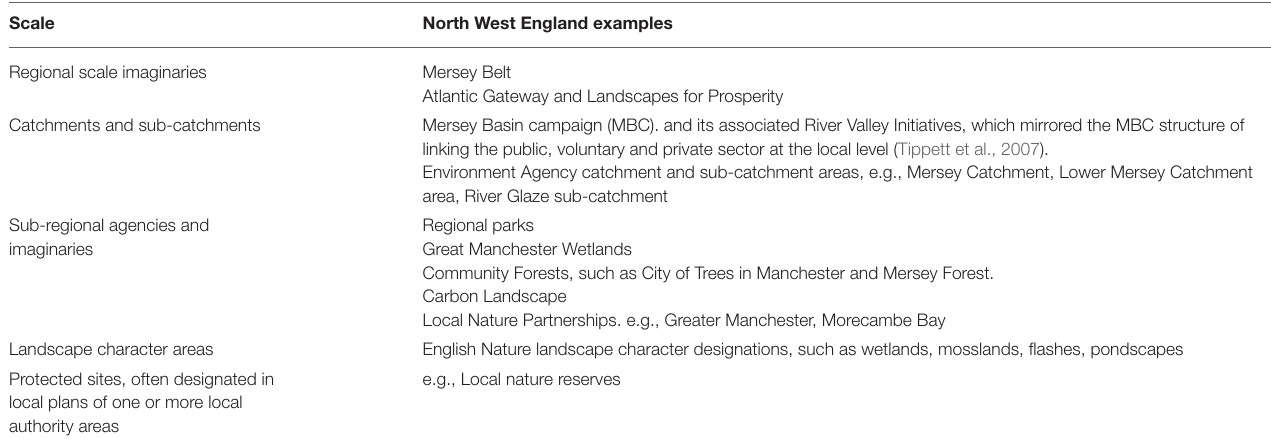
TABLE 2 | Scaling new geo-environmental spatial imaginaries: examples from North West England.